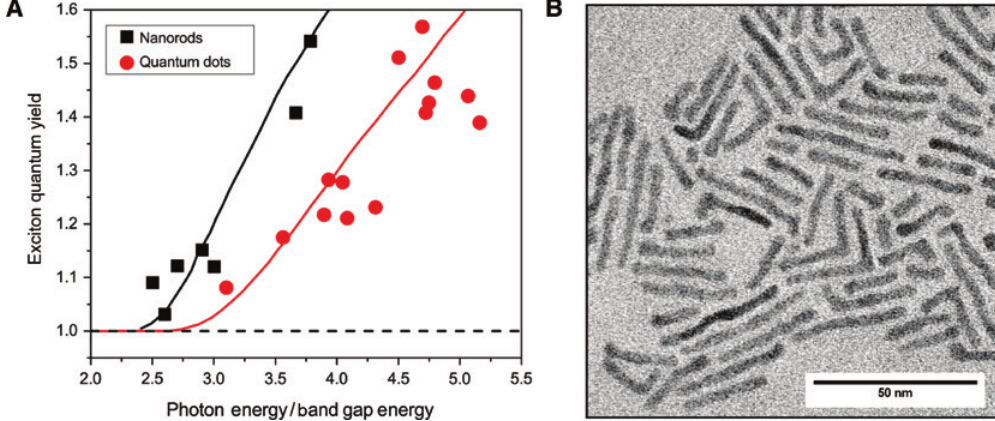
Figure 3: Enhancing quantum yields in 1D nanostructures. (A) Spectroscopically determined quantum yield of different lead selenide structures as a function of band gap-normalised photon energy. (B) Transmission electron microscopy images of as-synthesised lead selenide nanorods and their different shaped by-products. Part A has been reproduced from data provided in [46] and Part B has been taken from